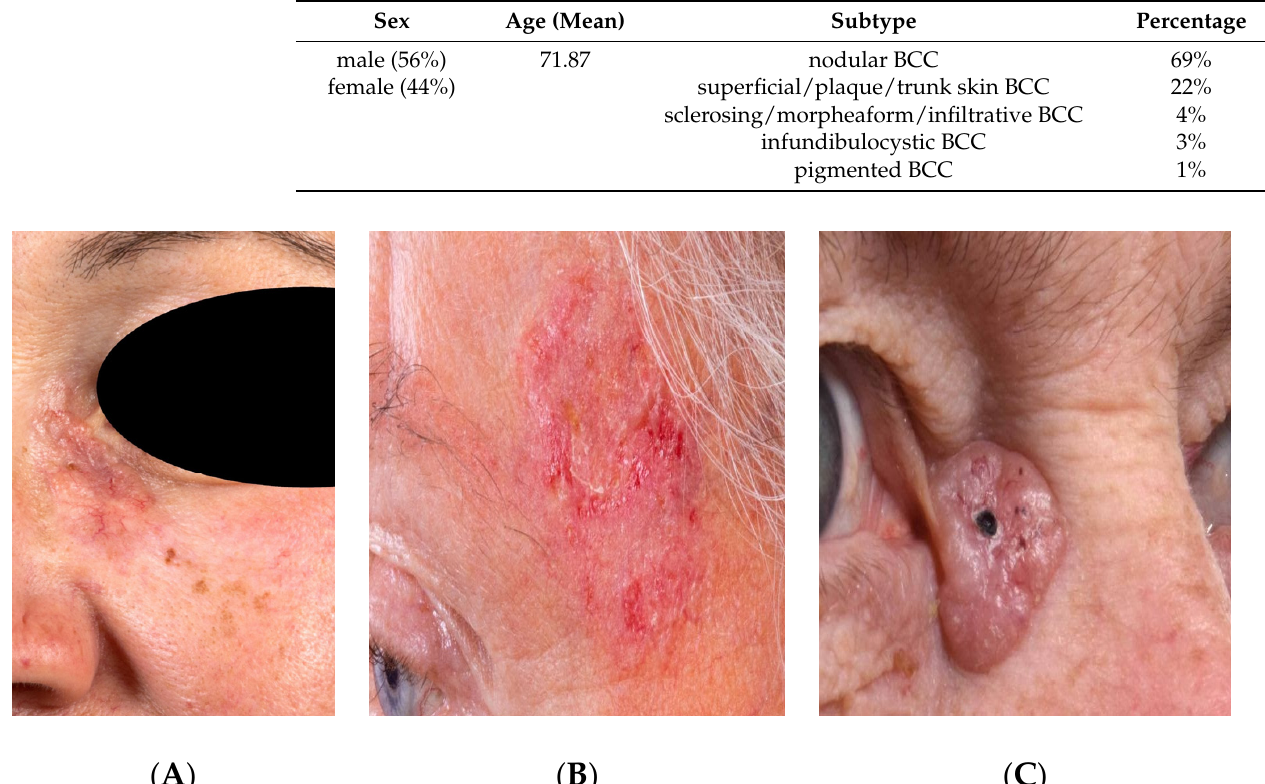
Table 1. Baseline characteristics of patients and tumor subtypes.